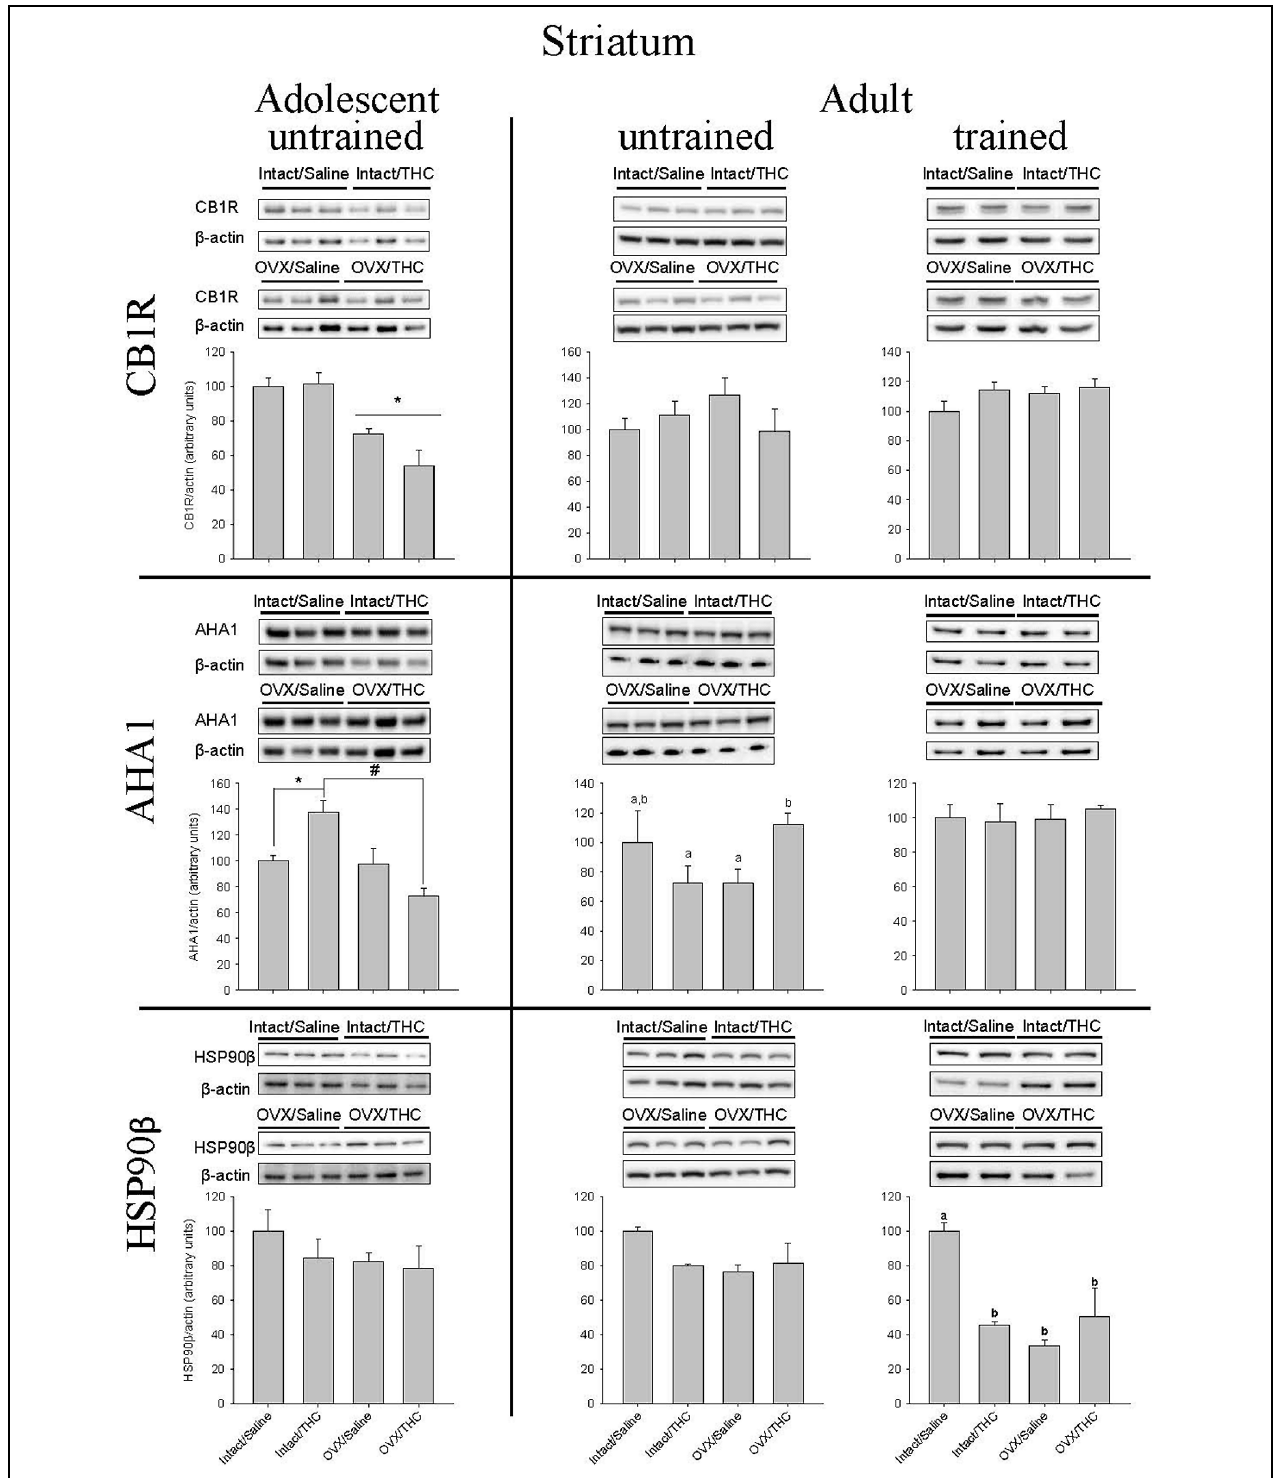
FIGURE 7 | Effects of chronic (cid:2) 9 -THC and hormone status on the endogenous levels of CB1R, AHA1, and HSP90 β in the striatum. Above each bar graph are western blots of protein levels in striatal extracts from the female rats in each of the four chronically treated groups. Levels of each protein were corrected for the β -actin levels in the same samples and presented as a